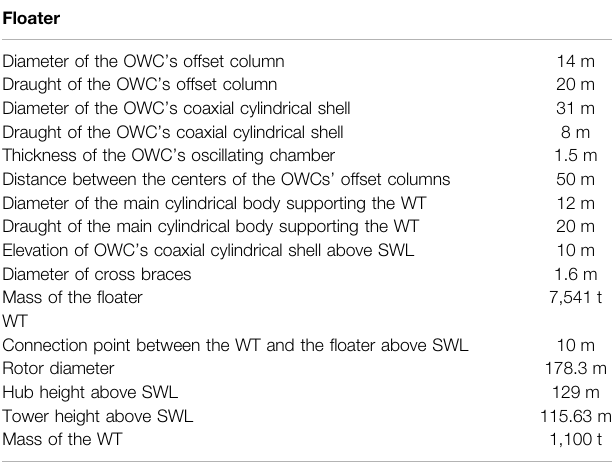
TABLE 1 | Geometric characteristics of the hybrid structure. Floater Diameter of the OWC ’ s offset column